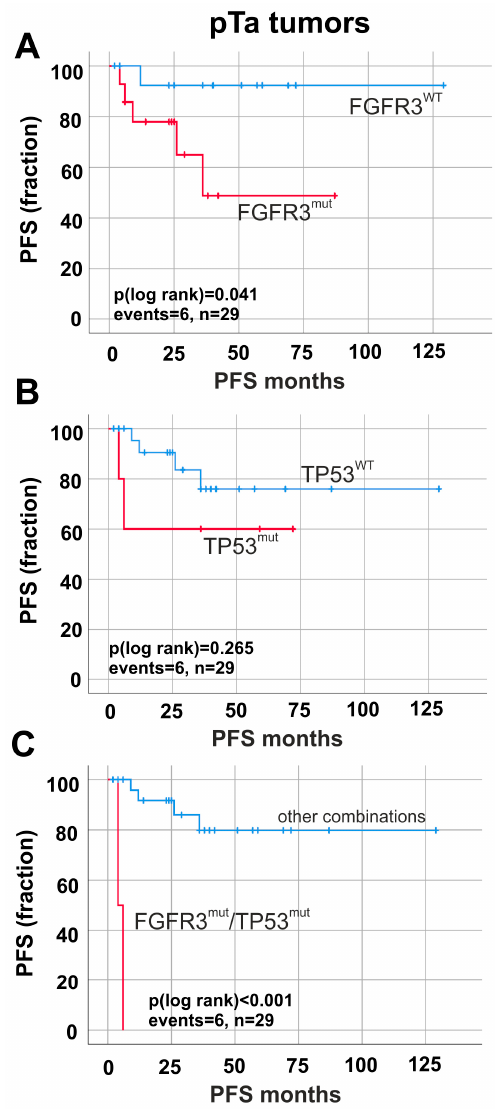
Figure 5. Prognostic impact of FGFR3 and TP53 mutations on tumor progression in papillary non-invasive (pTa) tumors. Progression-free survival (PFS) is shown. ( A ) Univariate survival analysis illustrates that detected FGFR3 mutations (red curve, n = 14) predict shorter PFS compared to non-mutated FGFR3 gene status (blue curve, n = 15). ( B ) Kaplan–Meier analysis of tumors with mutated TP53 (red curve, n = 5) compared to wildtype TP53 (blue curve, n = 24). ( C ) Impact of double mutations on risk stratification of tumor progression is shown. Survival analysis of double mutations (red curve, n = 2) compared to all other combinations of mutated and non-mutated FGFR3 and TP53 genes (blue curve, n = 27) in pTa tumors. n : overall number of cases; events: overall events of tumor progression.